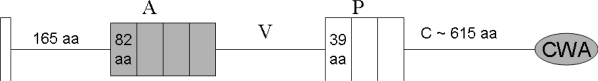
Schematic overview of the structural organization of antigen I/II polypeptides. All proteins contain a 38 residues leader peptide. 165 amino acid residues downstream of the leader peptide is the alanine-rich region containing 1–4 repeats of an 82 residues alanine-rich repeat. This is followed by a variable (V) region, followed by proline-rich P region containing 1–3 copies of a 39 residues repeat. The C-terminus shows ≥64% homology along the antigen I/II protein family. C-terminally is the cell wall anchoring sequence (CWA).